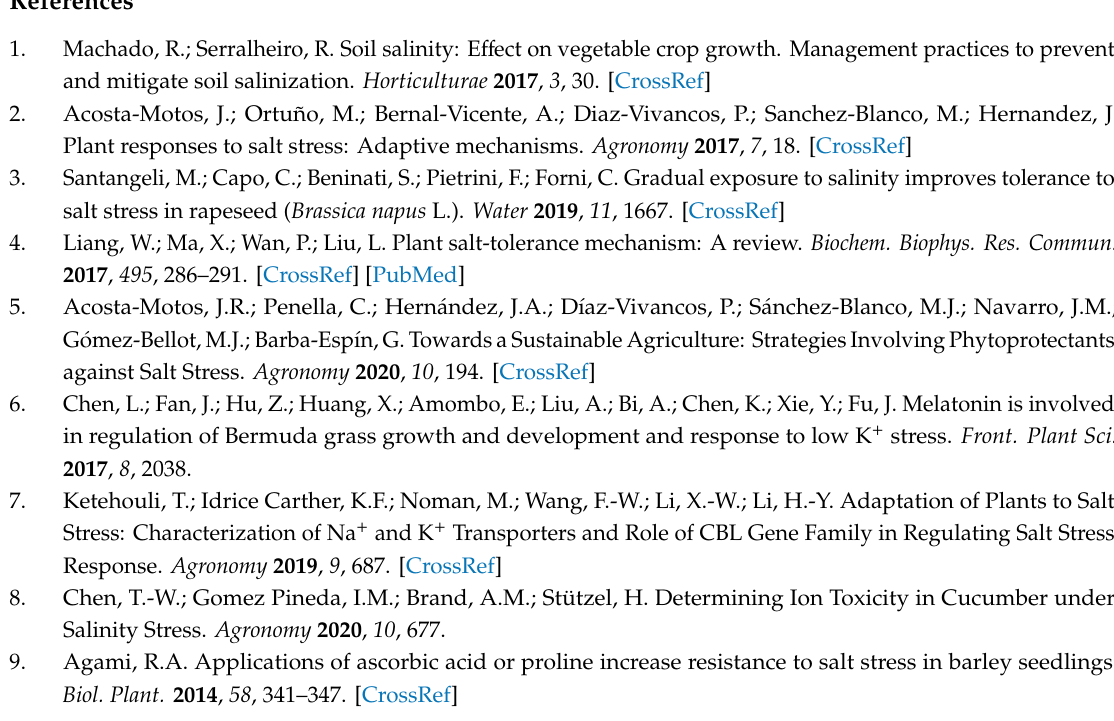
Table S1. Changes of green silique traits of two B. napus cultivars under two levels of sodium chloride stress and seed priming with di ff erent levels of melatonin. Table S2. ANOVA analysis based on moisture content, glucosinolate, erucic acid, and fatty acid composition traits in two B. napus cultivars at di ff erent levels of seed priming with melatonin under two levels of sodium chloride stress. Table S3. Changes of yield biomass traits in two B. napus cultivars under two levels of sodium chloride stress and seed priming with di ff erent levels of melatonin. Table S4. Responses leaf and stem anatomical features in two B. napus L. cultivars with melatonin seed priming and sodium chloride stress